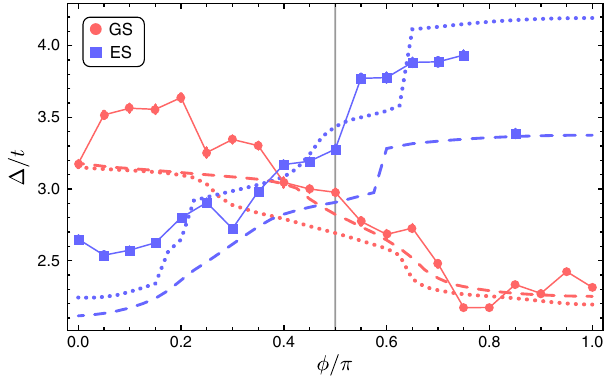
FIG. 5. Flux-dependent mobility edge. Empirically deter- mined critical disorder-to-tunneling strength ratios marking localization transition for ground state (GS, red circles) and highest excited state (ES, blue squares), as shown separately in Figs. 4(a) and 4(d). Noninteracting and interacting simulations ( U= ℏ ¼ 2 π × 500 Hz used in the latter) are shown as dashed and dotted lines, respectively. For flux values where no critical disorder is plotted, atomic population was determined to be delocalized (based on the set threshold value of the standard deviation) over the full range of disorder strengths. Vertical gray line at ϕ = π ¼ 0 . 5 denotes flux value at which the GS and ES curves should cross in the absence of interactions and any off-resonant coupling terms. Error bars denote 1 standard error of the